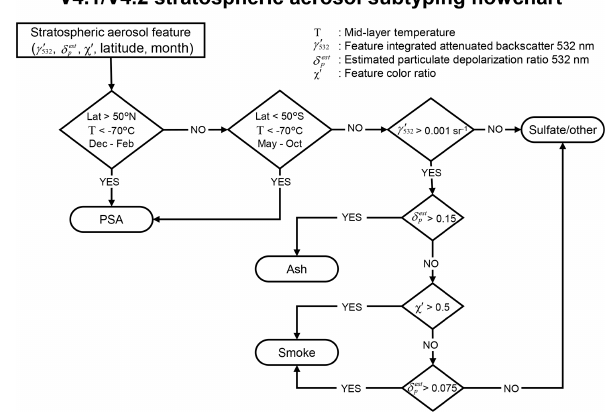
Figure 5. Flowchart for stratospheric aerosol subtyping in V4.2.